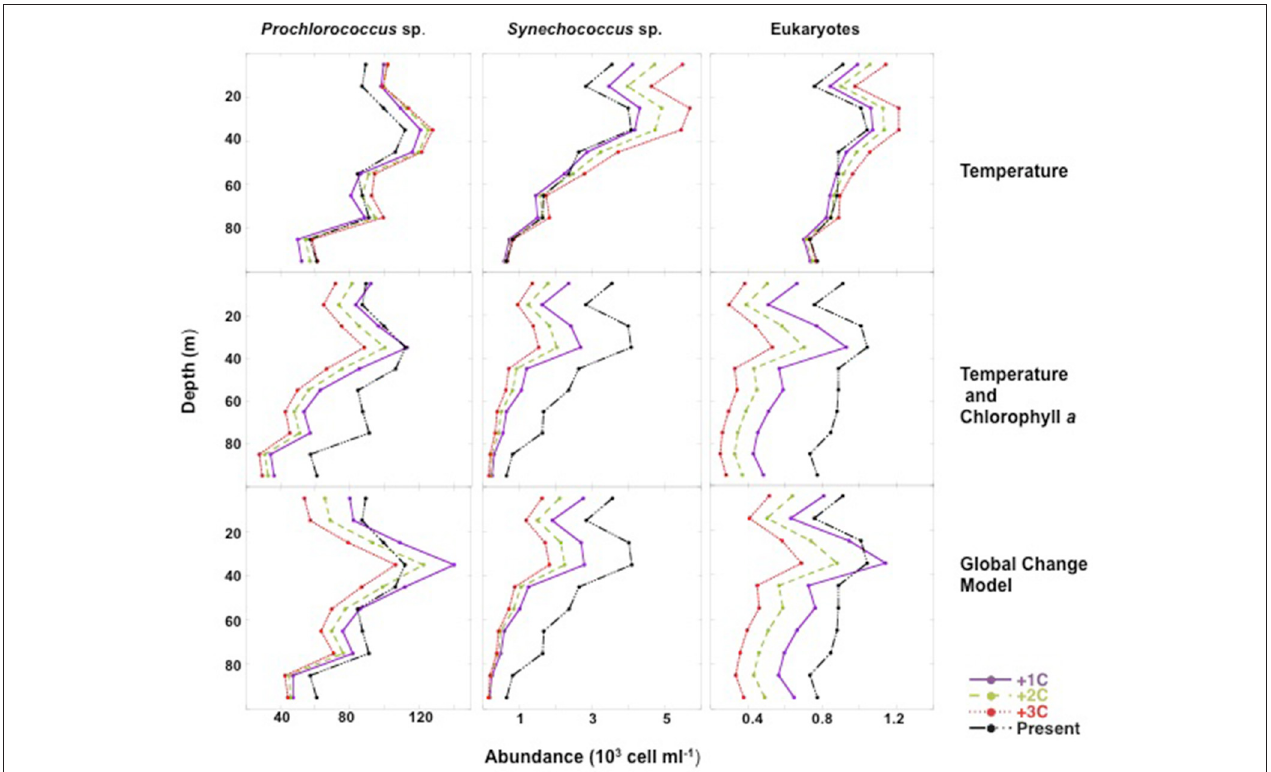
FIGURE 7 | Three warming scenarios (1 ◦ C, purple continuous lines; 2 ◦ C, green dashed lines; and 3 ◦ C, red dashed lines) were considered to predict the changes in the vertical profiles of Prochlorococcus , Synechococcus , and pico-eukaryotes by year 2100. Global present vertical profiles of abundance (black dashed lines) for each picophytoplankton population were obtained from the depth averaged abundances in the mixed layer obtained during the Malaspina-2010